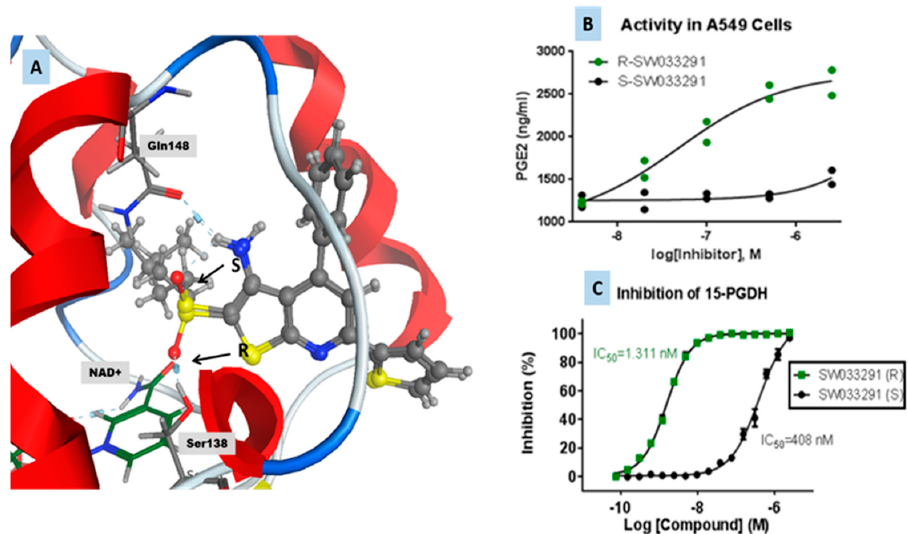
Figure 3. ( A ). Overlay of R versus S stereoisomers of SW033291. The oxygen of the sulfoxide in R- enantiomer exhibits hydrogen-bonding interactions with Ser138 and Tyr151. The S- stereoisomer prefers intramolecular hydrogen bonding. ( B ). PGE2 cell-based assay shows the ( R )-S(O)-SW033291 is relatively more active than ( S )-S(O) SW033291. ( C ). Percent inhibition (0–100%) of 15-PGDH enzyme activity of R versus S forms of SW033291.